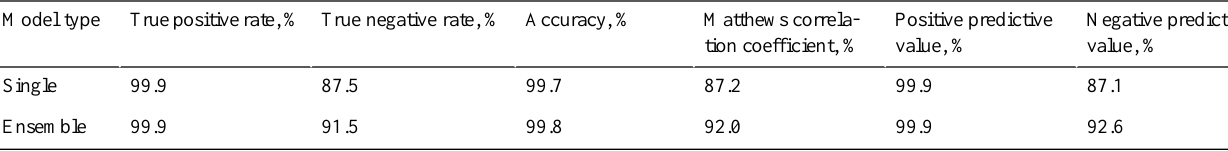
Table 1. Results of the convolutional neural network classifier for cough recognition.